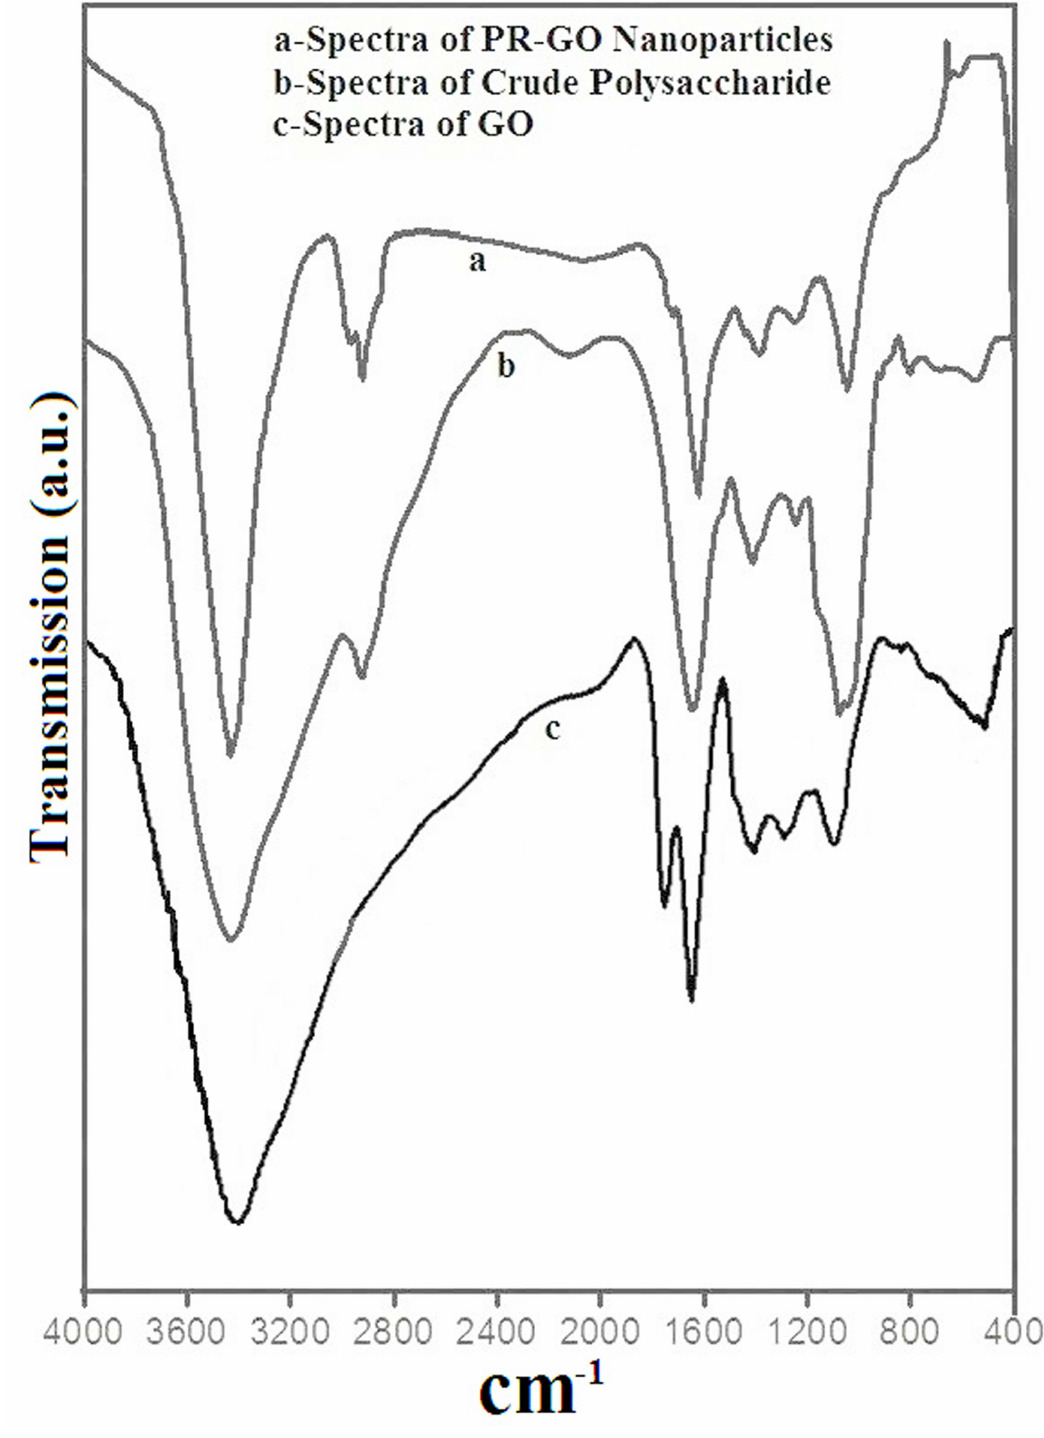
Fig 7. Fourier transform infrared spectra of (a) PR-GO; (b) Crude polysaccharideand (c) GO.